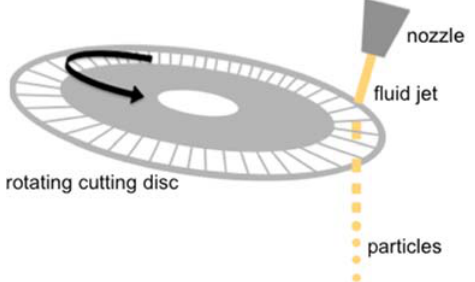
Figure 1. Schematic representation of the jet cutting process. The chitosan solution was pressed out of the nozzle as a fluid jet and cut into cylinders by the cutting disc. The cylinders acquired the spherical shape of droplets before falling into the gelation bath due to surface tension.